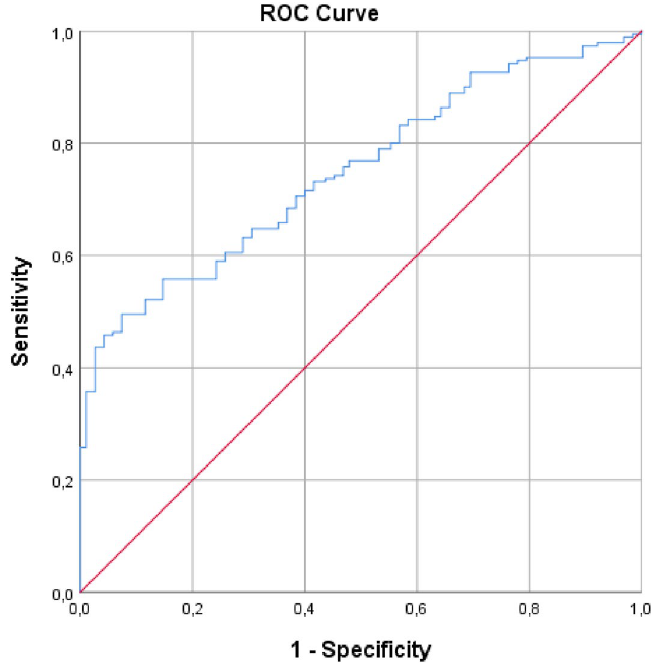
Figure 4. The area under the ROC curve AUROC.